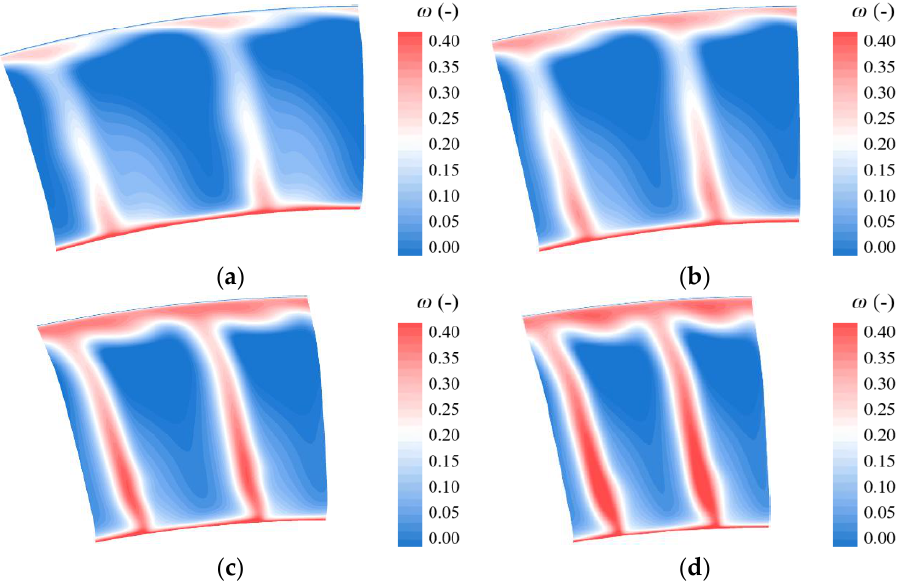
Figure 20. The distribution of total pressure loss at rotor outlet for the design point: ( a ) ψ = 0.41; ( b ) ψ = 0.47; ( c ) ψ = 0.55; ( d ) ψ = 0.65.